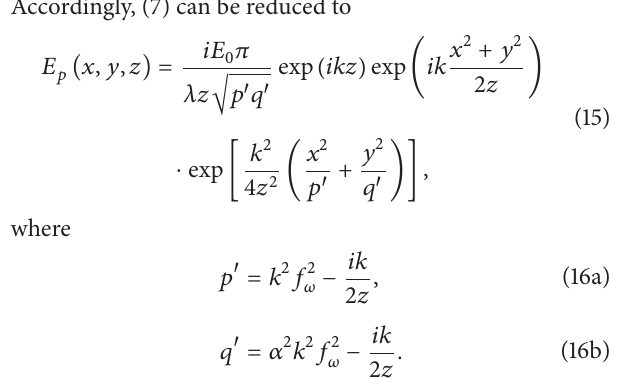
Figure 1: Intensity distribution of elliptical Gaussian beam for 𝑓 𝜔 = 0.01 as a function of 𝑥 in free space in different planes: (a) 𝑧 = 0 ; (b) 𝑧 = 5𝑧 𝑧 = 10𝑧 𝑧 = 20𝑧 𝑧 = 𝑧 𝑟 ; (c) 𝑟 ; (d) 𝑟 ; (e) 𝑟 . Several curves correspond to different elliptic coefficient curve); 𝛼 = 1.5 (dotted